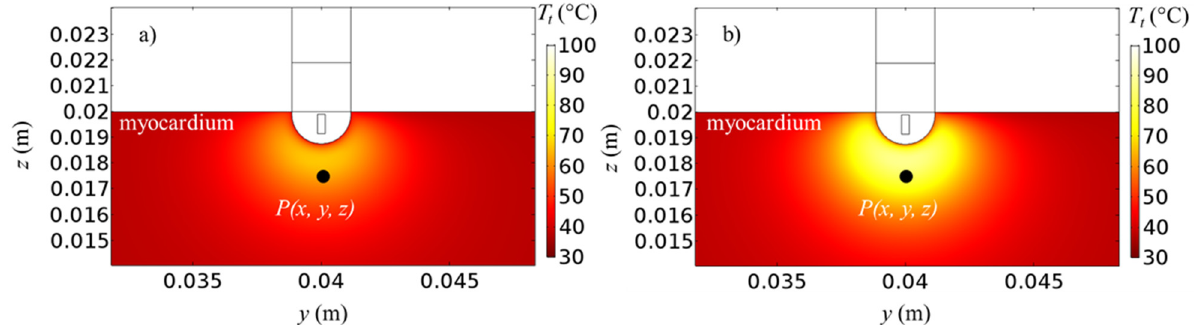
Figure 4. Tissue temperature fields at t = 60 s for | u | in = 0.05 m/s, ω * = 0.125, ( a ) V 0 = 20 V and ( b ) V 0 = 25 V.